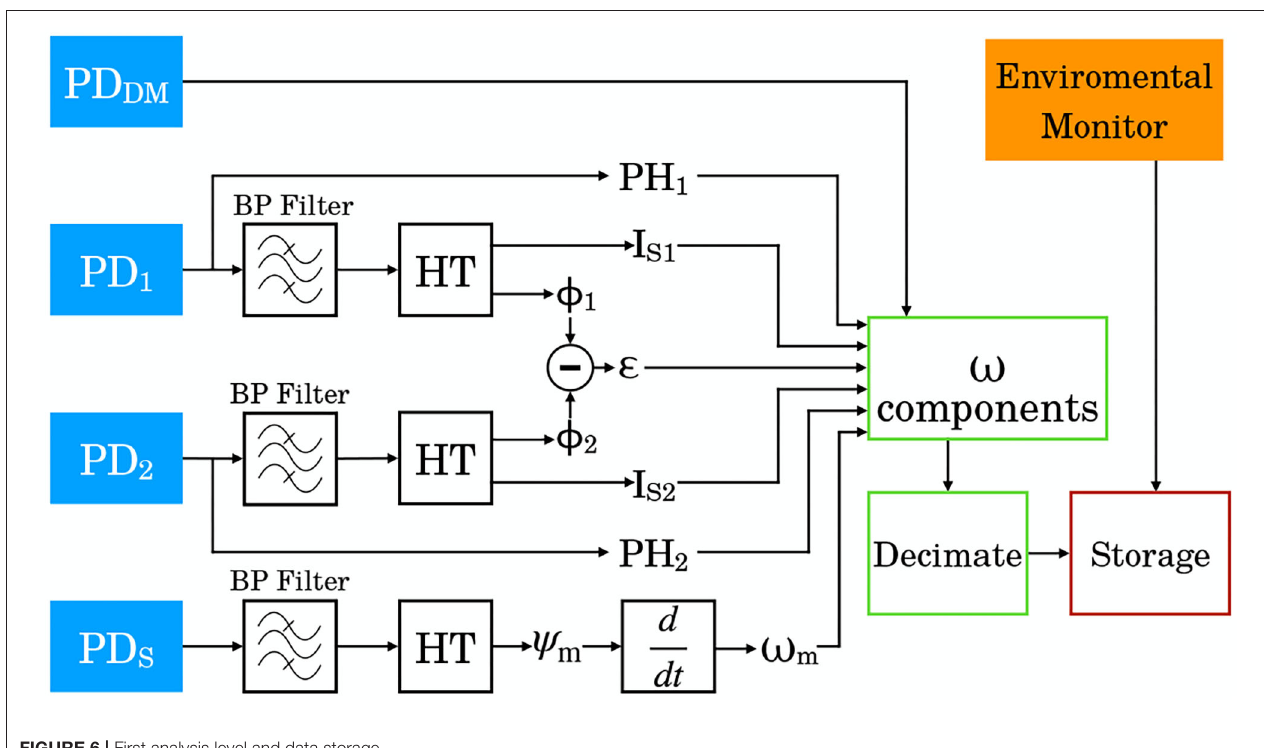
FIGURE 6 | First analysis level and data